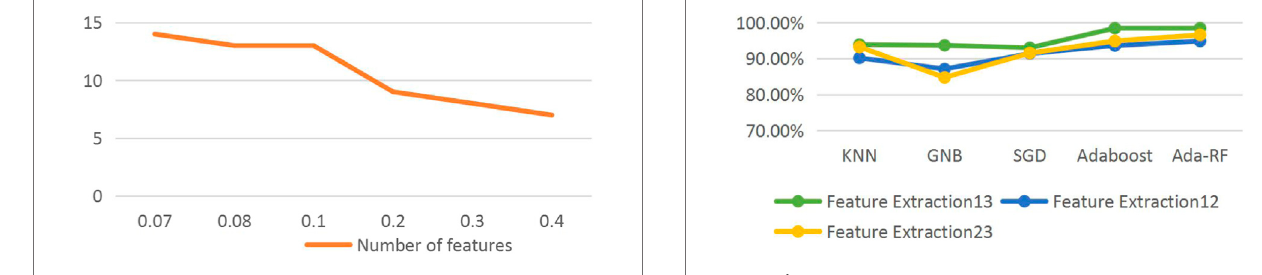
FIGURE 1 | Number of feature extraction corresponding to minsupport.